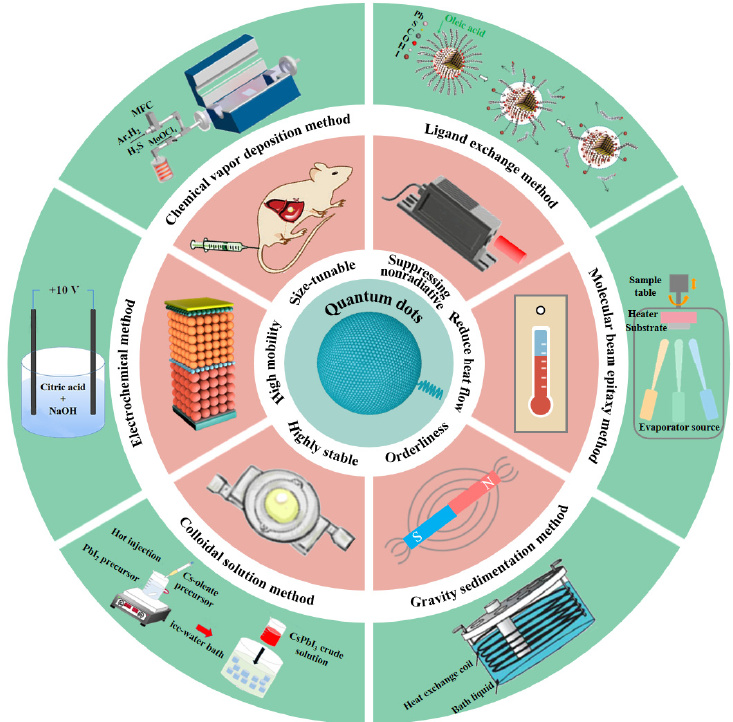
Figure 1. The performance optimization and methods of self-assembled QDs.